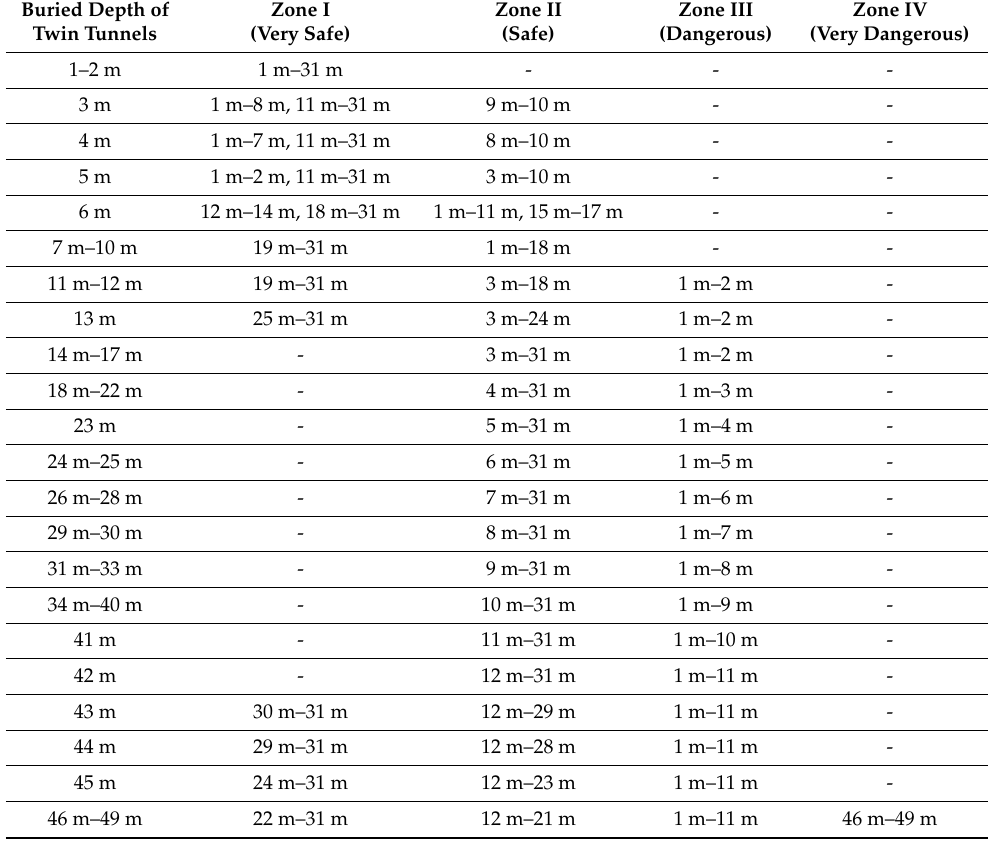
Table 7. Safety risk level partition of adjacent construction. Buried Depth of Twin